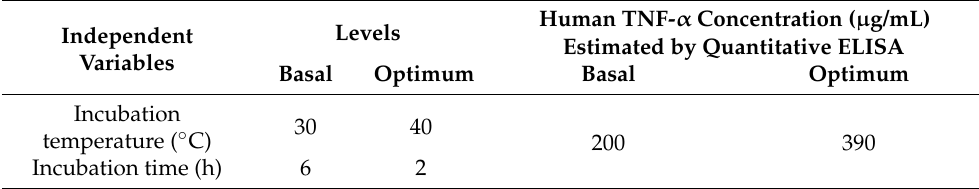
Table 8. Recombinant human TNF- α cell-free synthesis before and after